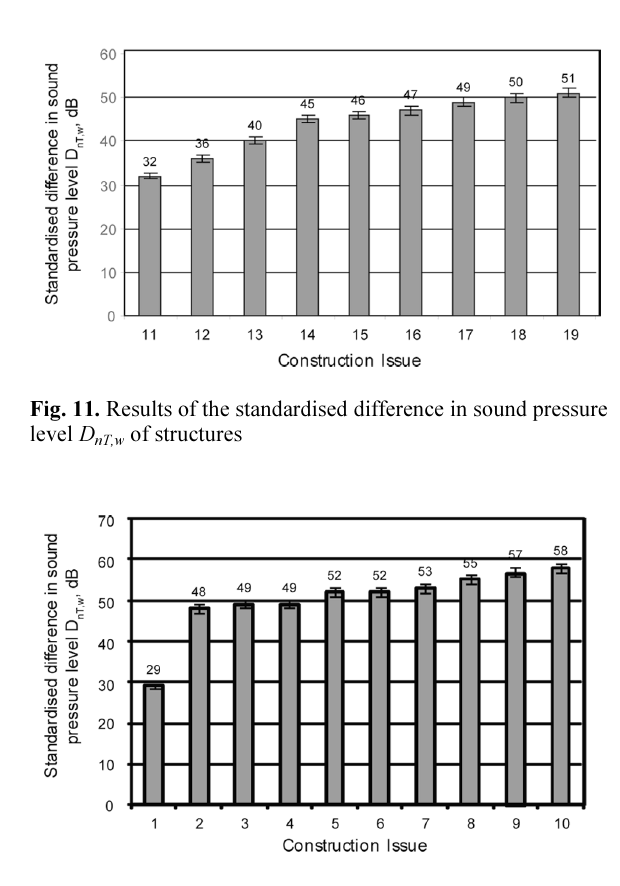
Fig. 10. Structures of experimental specimens of the log wall